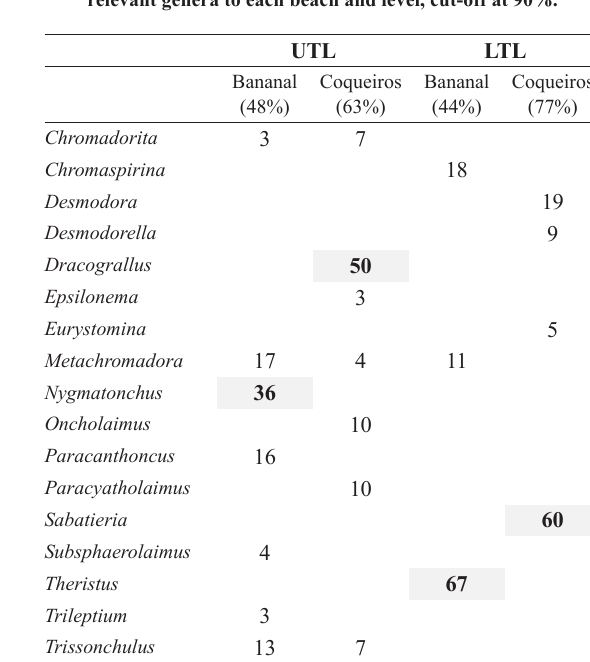
SIMPER-list showing the contribution (%) of the most relevant genera to each beach and level, cut-off at 90%.